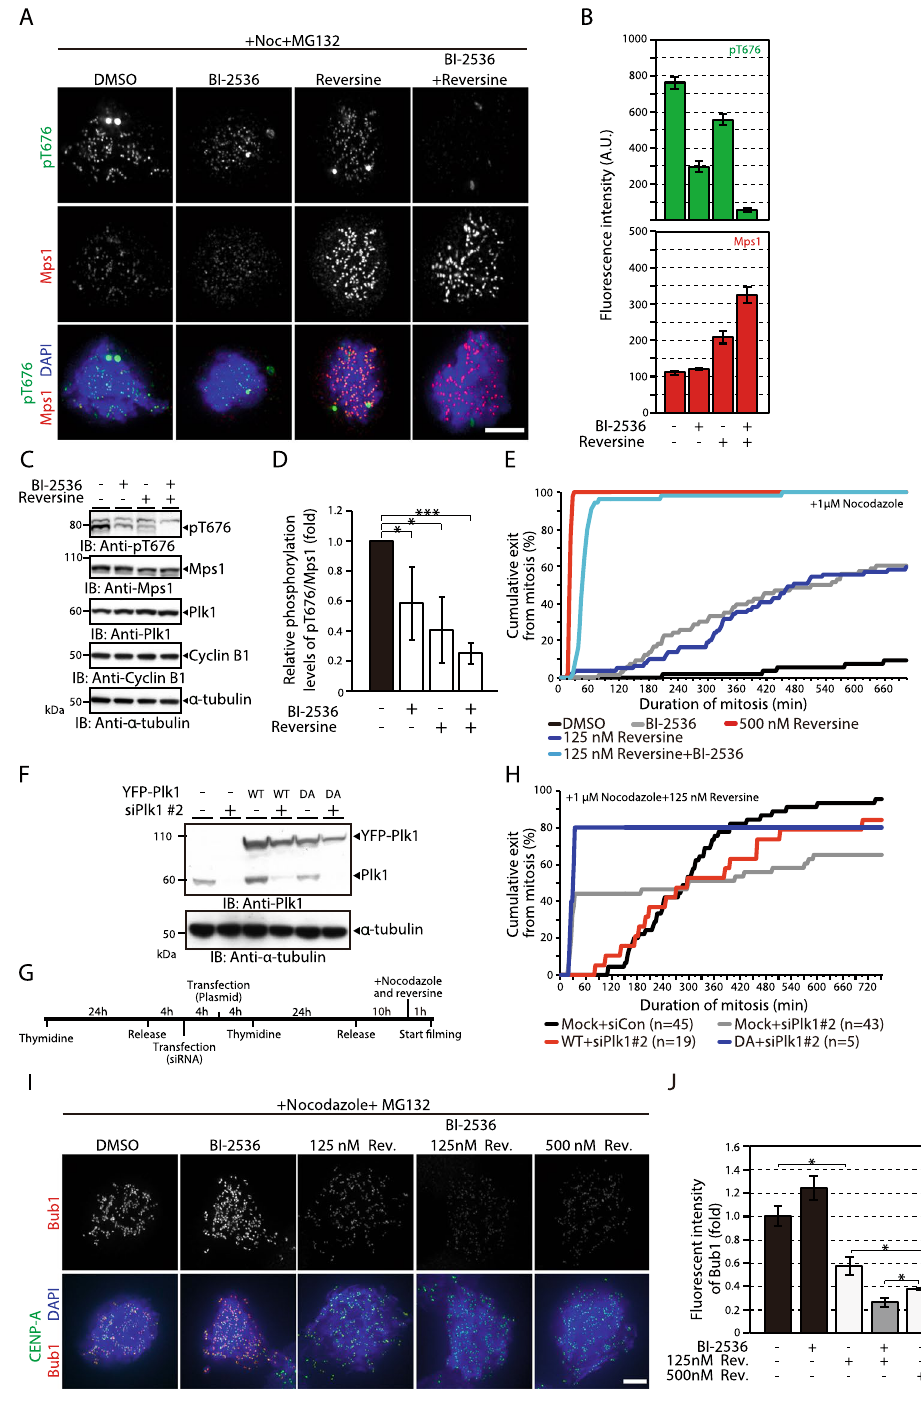
Figure 2. Plk1 is involved in the activation of Mps1 on kinetochores and the maintenance of SAC activity. ( A ) Phosphorylation of Mps1 on kinetochores in Plk1- and/or Mps1-inhibited HeLa cells. Mitotic HeLa cells were treated with 300 nM BI-2536 and/or 500 nM reversine in the presence of nocodazole and MG132, fixed and stained with antibodies against phospho-Thr676 (pT676) of Mps1 (green) and Mps1 (red). DNA was stained with DAPI (blue). Scale bar: 5 μ m. ( B ) Quantification of pT676 and total Mps1 signal on kinetochores. The fluorescence intensity of pT676 of Mps1 and total Mps1 in cells treated as in ( A ) is shown. At least 76 kinetochore signals per cell (5 cells) were quantified for each condition. The experiments were repeated three times, and the representative dataset collected from a single experiment was shown. A.U: arbitrary units. Error bars represent S.E. ( C ) Phosphorylation of Mps1 in Plk1- and/or Mps1-inhibited cells. HeLa cells treated with 300 nM BI-2536 and/or 500 nM reversine were lysed and subjected to western blotting analysis with antibodies as indicated. ( D ) Quantification of pT676 to total Mps1 ratio in HeLa cells treated as in ( C ). The ratio in DMSO- treated cells was set as 1. Error bars represent S.D. of three experiments. * P < 0.05; *** P < 0.0001 (two-tailed t - test). ( E ) Plk1 contributes to SAC maintenance. The cumulative frequency of cells treated with reversine